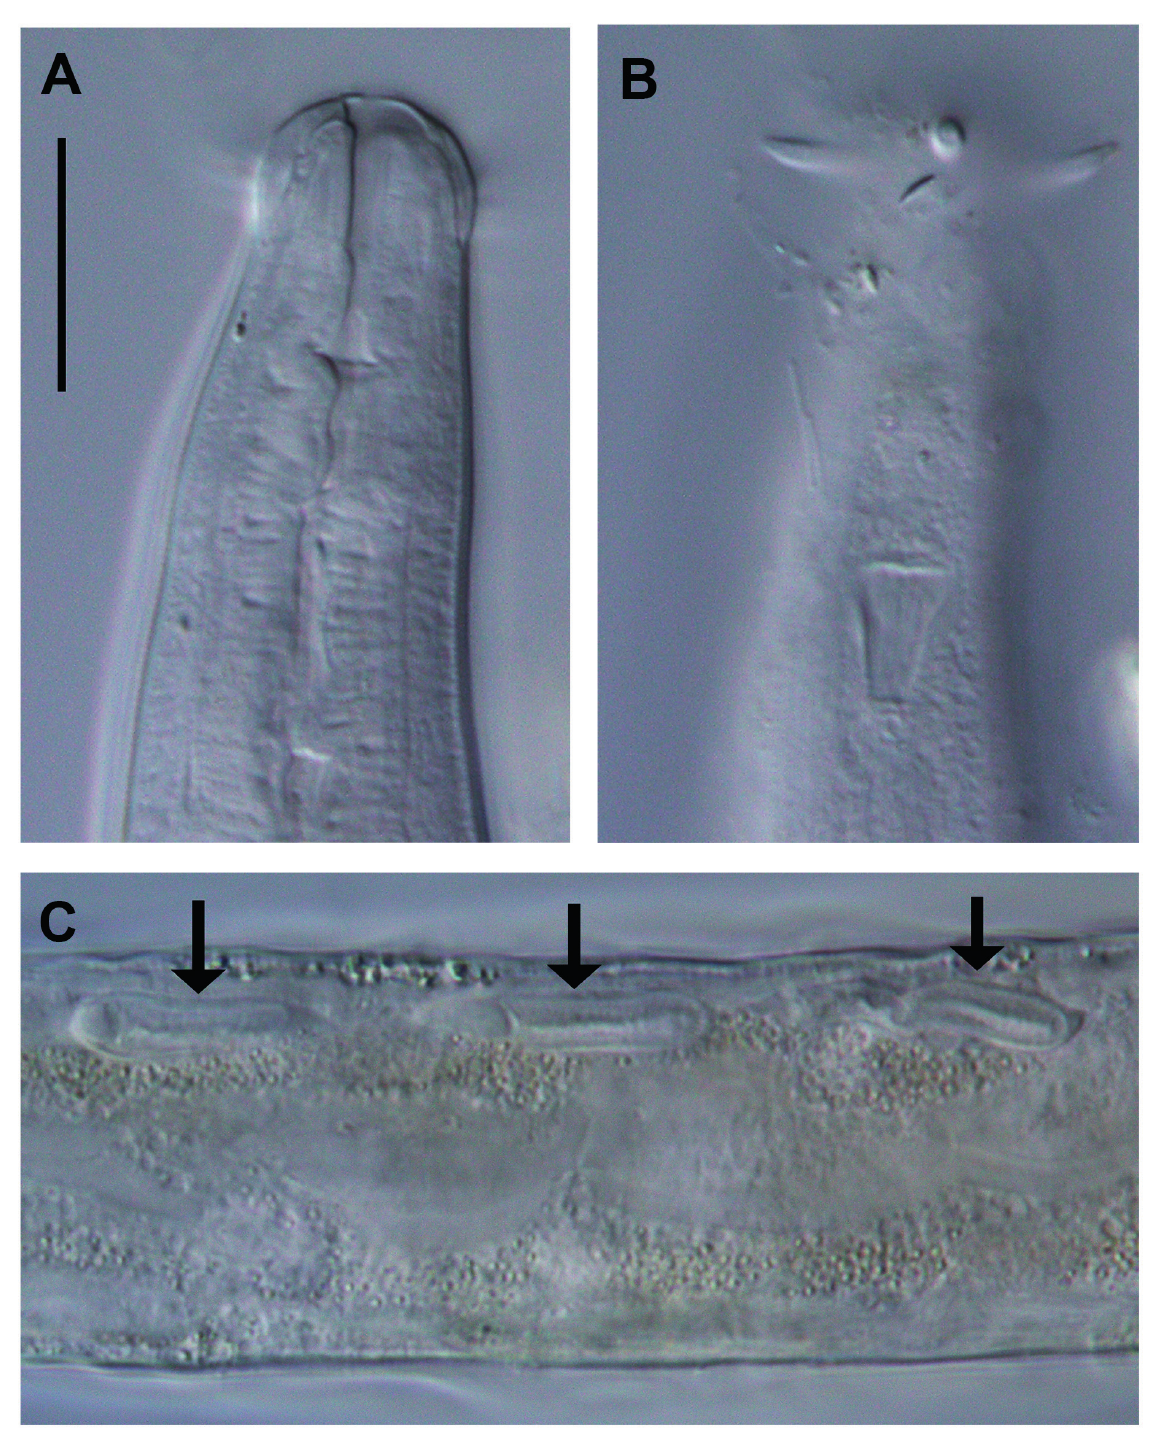
Figure 4. Trefusialaimus idrisi Leduc, 2013, ♀ (NIWA139242), light micrographs. A . Optical cross- section of cephalic region showing buccal cavity, lips and pharynx. B . Surface view of cephalic region showing outer labial setae and amphid. C . Mid-body region showing intestine and sperm cells in pseudocoelom (arrows). Scale bars: A–B = 15 μm; C = 22